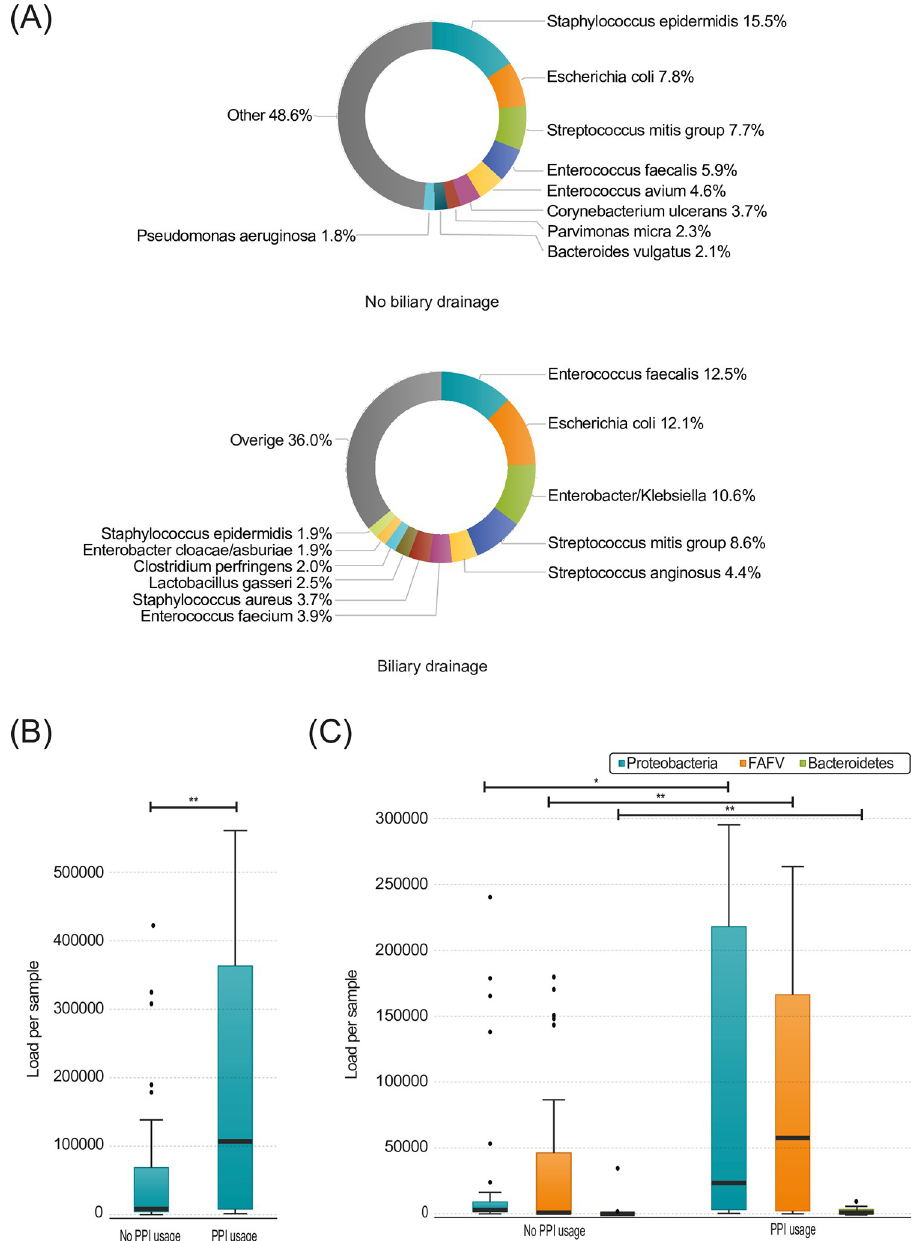
Fig 3. (A) Species present in pancreatic biopsy samples with and without biliary drainage. Percentages are calculated over the total amount of bacteria. (B) Total load in pancreatic biopsies, divided by patients (n = 20) and without (n = 31) PPI usage (p = 0.007) (C) Load per phylum in pancreatic biopsies, divided by patients (n = 20) and without (n = 31) PPI usage (FAFV p = 0.008). Boxplots: Black bar denotes median, box denotes the interquartile range, whiskers indicate the range of values that are outside of the interquartile range. Outliers are defined as > 1.5 times the size of the interquartile range and presented as a black dot. Abbreviations: PPI: Proton pump